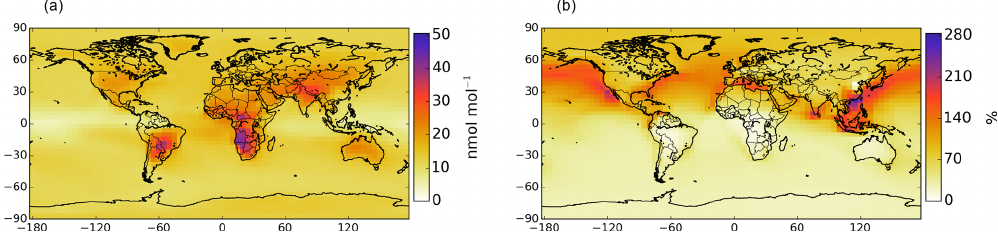
Figure 2. (a) O 3 surface concentration in the preindustrial and (b) percent change from the preindustrial to present day ( ( PD − PI )/ PI ·